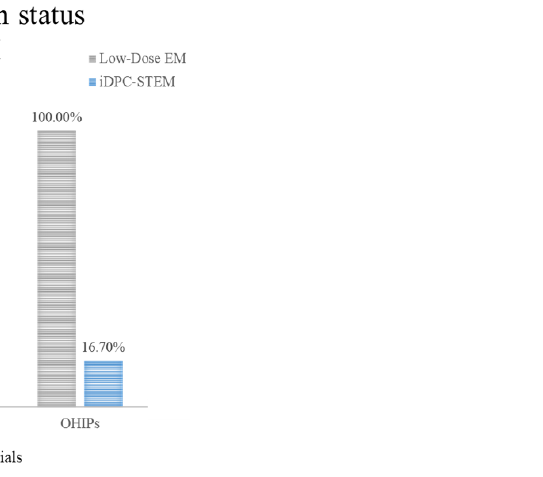
Figure 3. Application status of iDPC ‐ STEM in electron beam sensitive materials characterization.